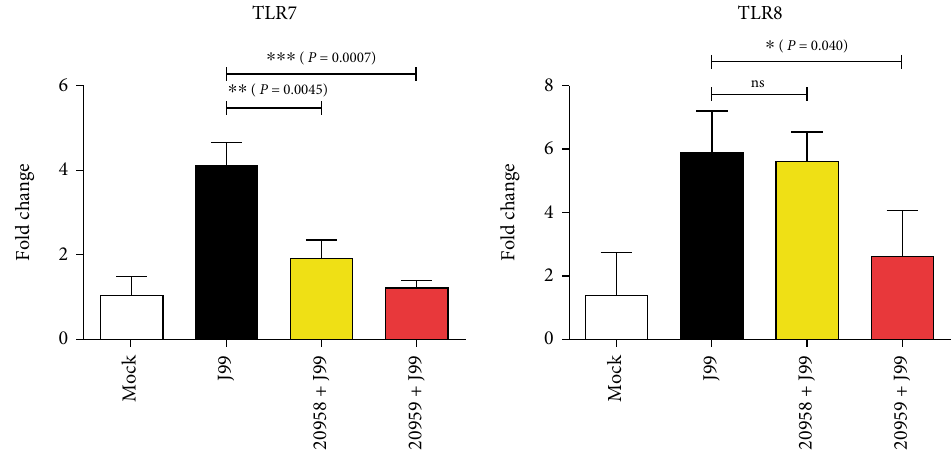
Figure 4: E ff ect of TLR7/8 antagonists on TLR7 and TLR8 expression THP-1 cells. THP-1 cells were uninfected (mock), infected with H. pylori J99 strain at MOI 10 for 16 hours (J99), or treated with TLR7 inhibitor (ODN20958+ J99) or TLR7/8 inhibitor (ODN20959 +J99) for 4 hours prior to infection. Expression levels of TLR7 transcript were downregulated by both ODN20958 and ODN20959, whereas the expression of TLR8 transcript was downregulated by ODN20959 alone, suggesting speci fi city of the antagonists. Data is presented as mean ± SD from one experiment run in triplicate and is representative of two independent experiments. Statistical signi fi cance was analyzed using Student ’ s t -test ( ∗ P ≤ 0 : 05 ; ∗∗ P ≤ 0 : 01 ; ∗∗∗ P ≤ 0 : 001 ; ns : not signi fi